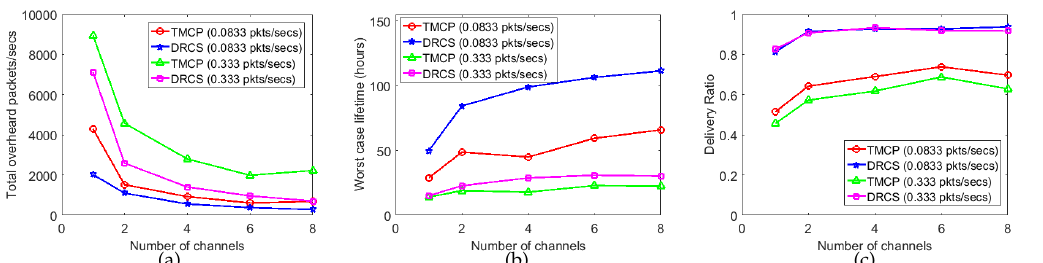
Figure 12. Comparison of ( a ) network-wide packets overheard; ( b ) worst case network lifetime and ( c ) packet delivery ratio with different number of